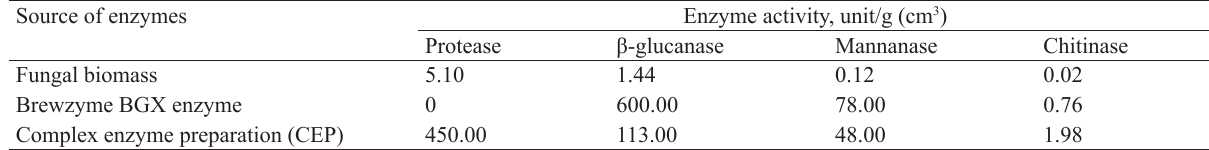
Table 2 Enzymatic activity of enzyme preparations used for biocatalysis of the microbial biomass mix ( Aspergillus oryzae and Sаcharomyces cerevisiae )